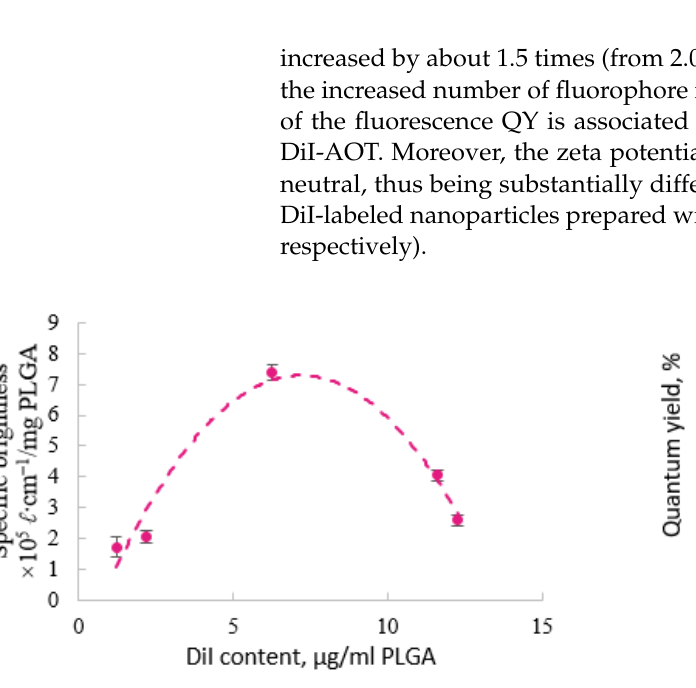
Figure 2. Influence of DiI content in PLGA nanoparticles on their specific brightness ( left ) and on quantum yield ( λ EX 488 nm) ( right ).